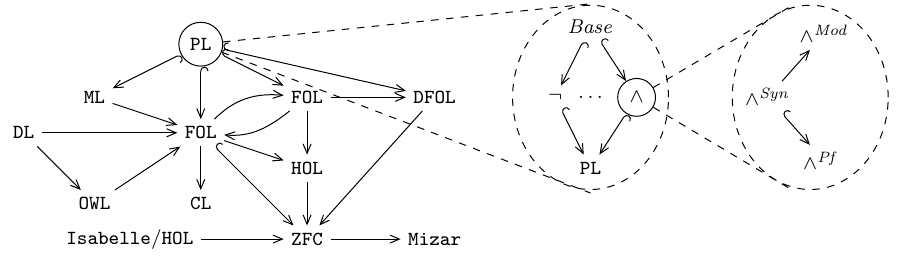
Fig. 7. A Fragment of the LATIN